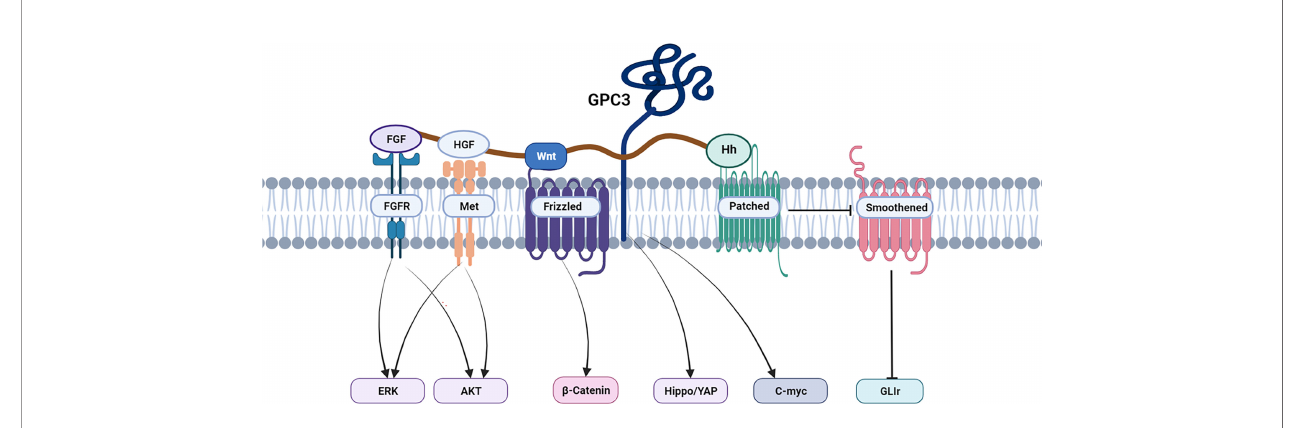
FIGURE 3 | GPC3 associated signaling pathways